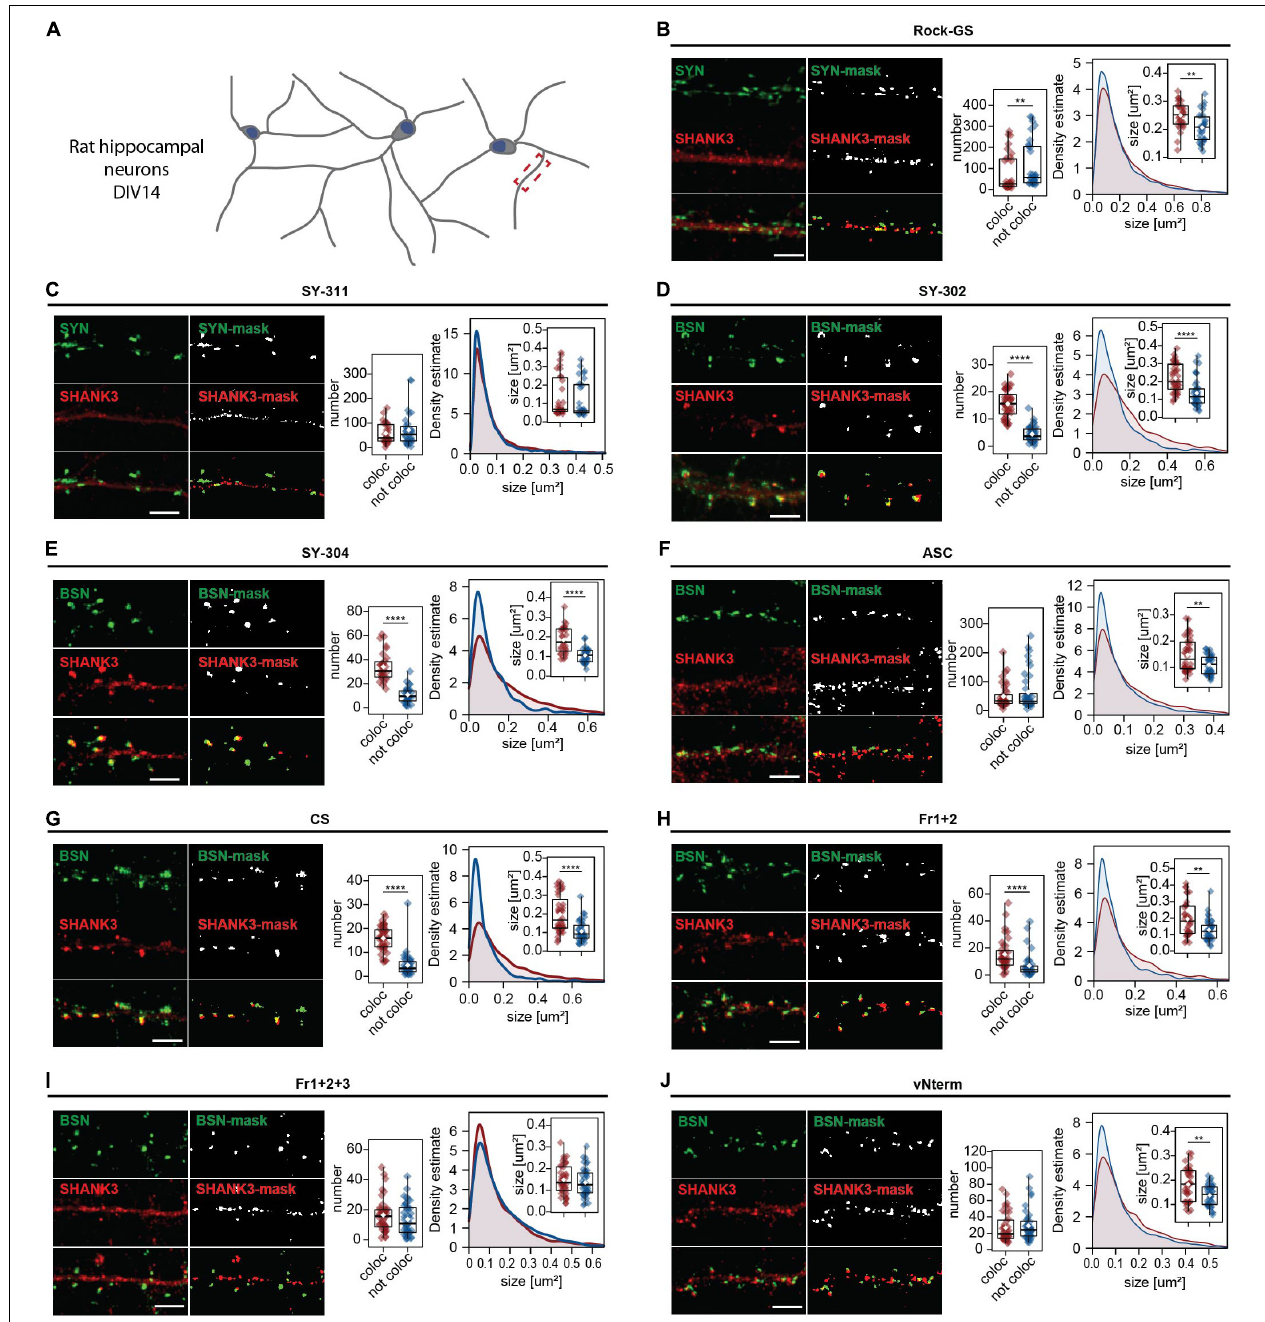
FIGURE 4 | ICC analysis in primary rat hippocampal neurons. (A) Neurons have been fixed at DIV14 and secondary dendrites were analyzed. Cells were stained against MAP2, SYNAPSIN1/2, or BASSOON and (B) Rock-GS, (C) SY-311, (D) SY-302, (E) SY-304, (F) ASC, (G) CS, (H) Fr1+2, (I) Fr1+2+3, and (J) vNterm. Scale bar 5 µ m. ICC and the derived mask obtained in ImageJ with FindFoci are shown. Left graph: Number of synapses. SHANK3 puncta co-localizing with the respective pre-synaptic marker (red) or not co-localizing (blue) are shown. Right graph: Size of SHANK3 puncta and estimated density. The boxplot shows the median and the interquartile range, the whiskers cover minimal to maximal values. The white dot marks the mean. Data collected from a total of 40 cells of 4 independent experiments. Groups were tested for normality using the Shapiro–Wilk test and then compared using the Wilcoxon test. ** p ≤ 0.01, **** p ≤ 0.0001.